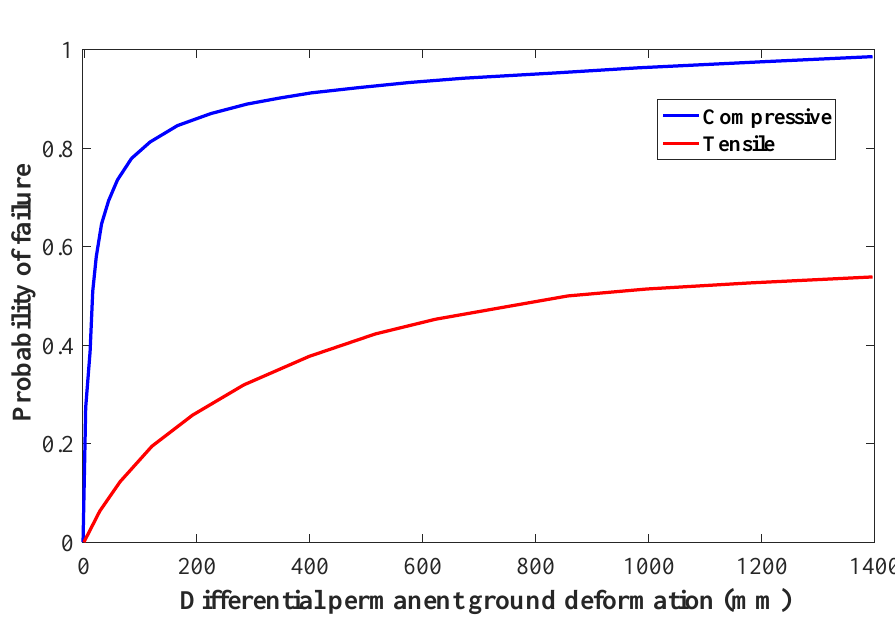
Figure 11. Fragility curve for pipeline damage using [58] strain